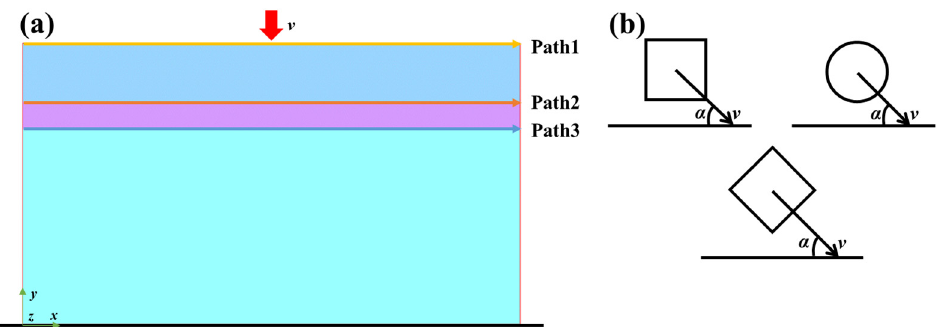
Figure 4. ( a ) defined boundary conditions and paths of the model, ( b ) model maps of contact forms, erosion angles and velocities of CMAS particles.